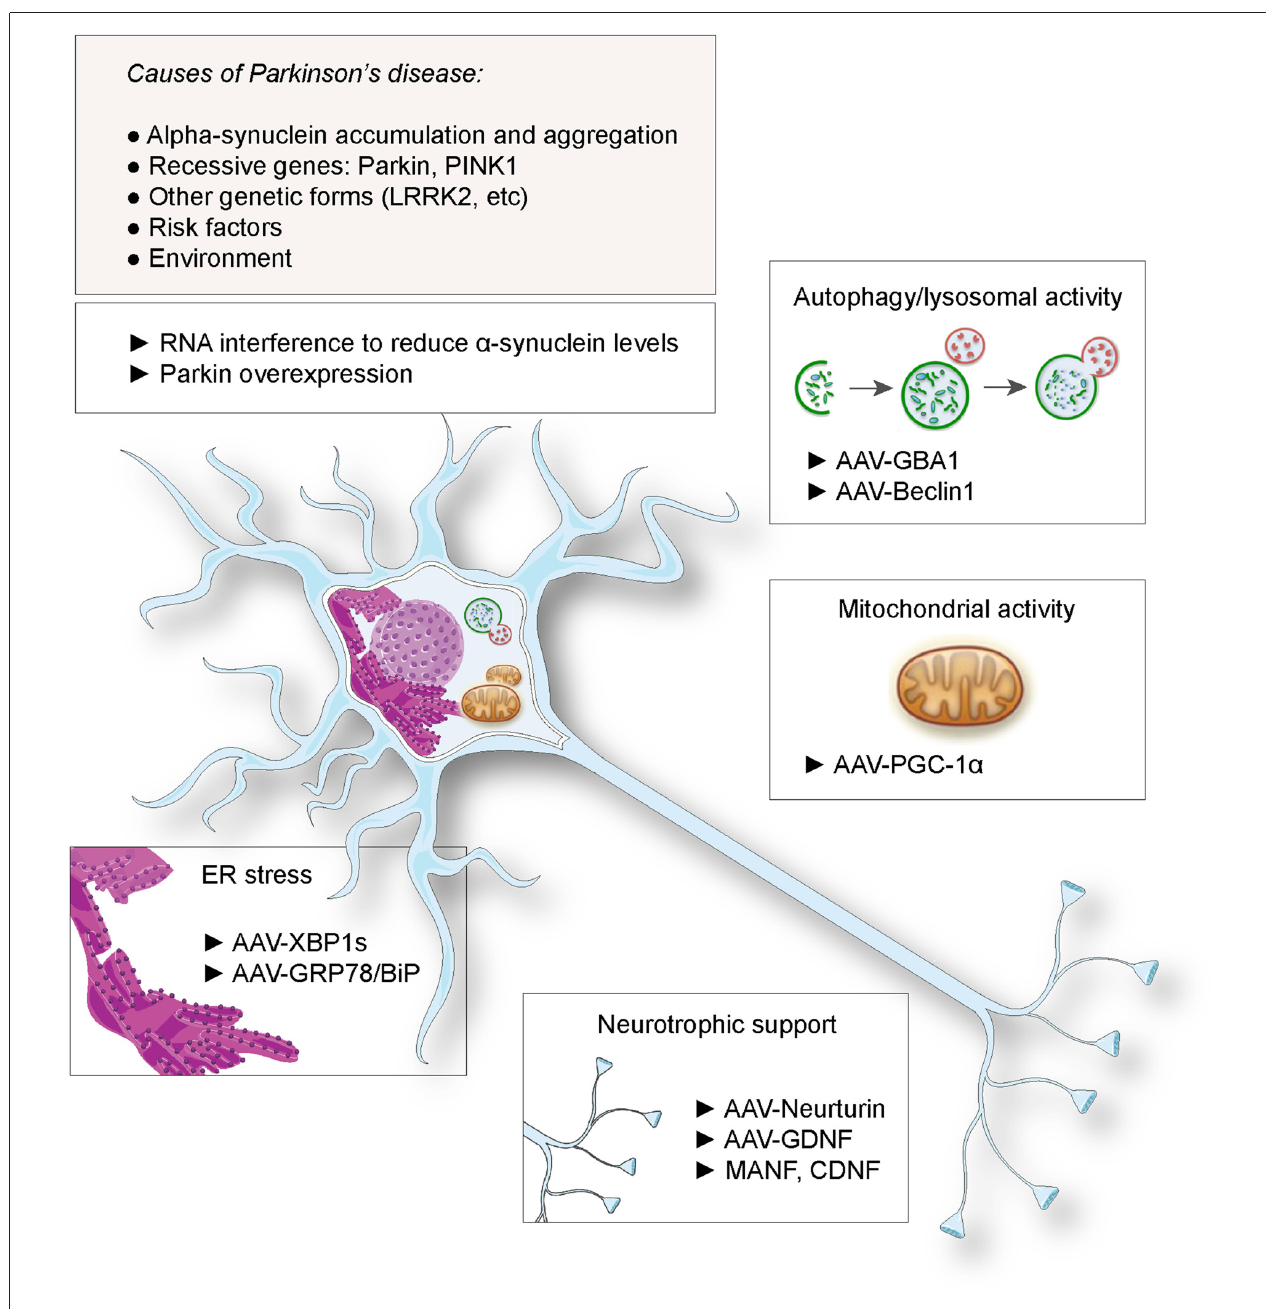
FIGURE 1 | Proposed gene therapies for neuroprotection against Parkinson’s disease (PD). Based on the identified causes and risk factors for PD, various strategies have been envisaged, including RNA interference against α -synuclein and Parkin overexpression. Gene transfer has been proposed to deliver neurotrophic factors to rescue dopaminergic function, factors to suppress endoplasmic reticulum (ER) stress, enhance lysosomal and mitochondrial